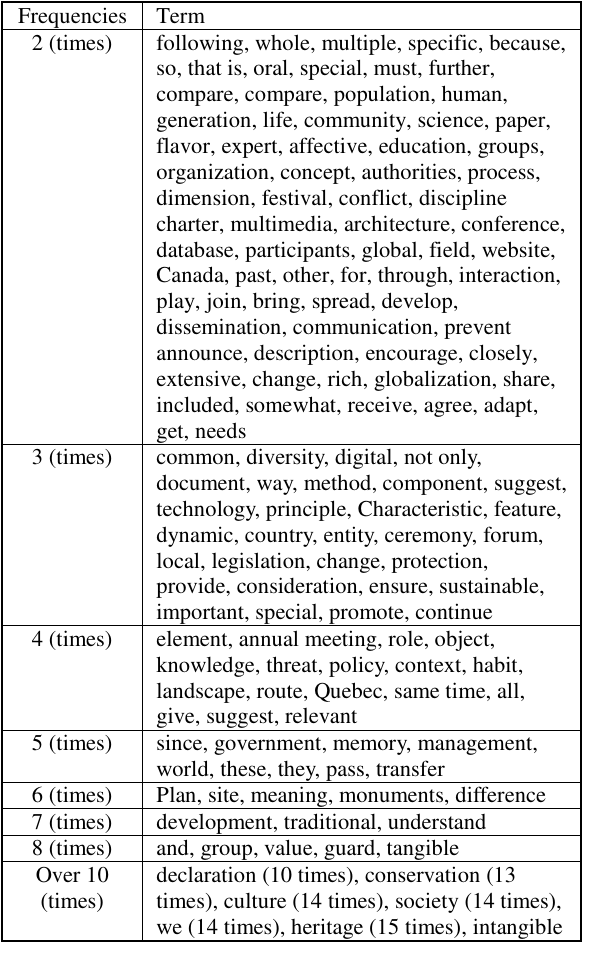
Table 4 Frequency of keywords in “Quebec Declaration”